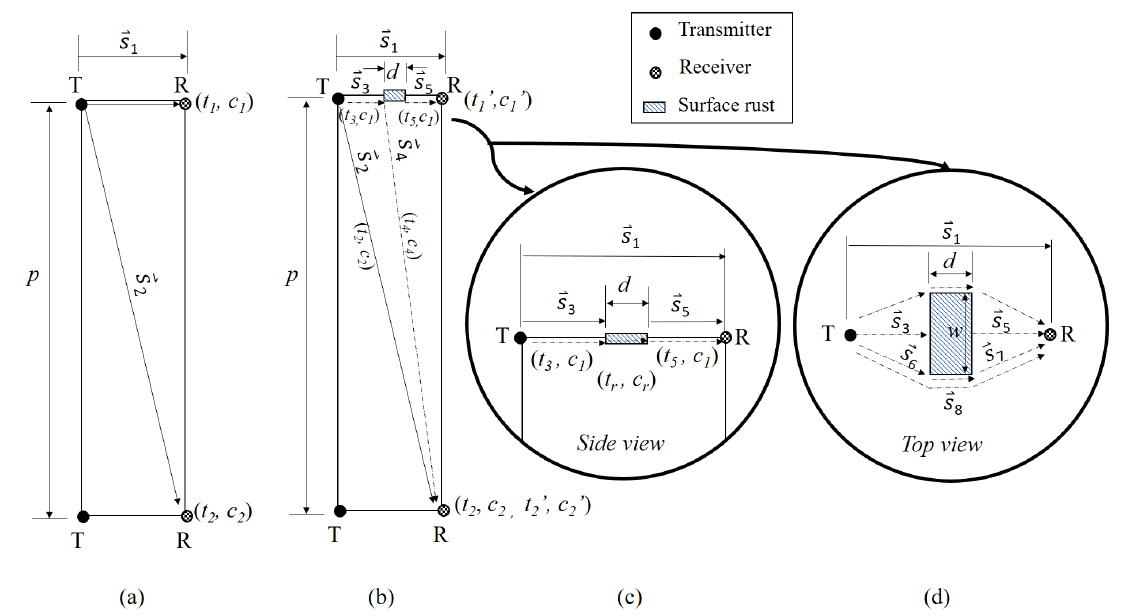
Figure 3. ( a ) Mercator projection of intact steel rod model surface; ( b ) Mercator projection of corroded steel rod model surface; ( c ) side view of ultrasonic wave propagation paths around the surface rust; and ( d ) top view of ultrasonic wave propagation paths around the surface